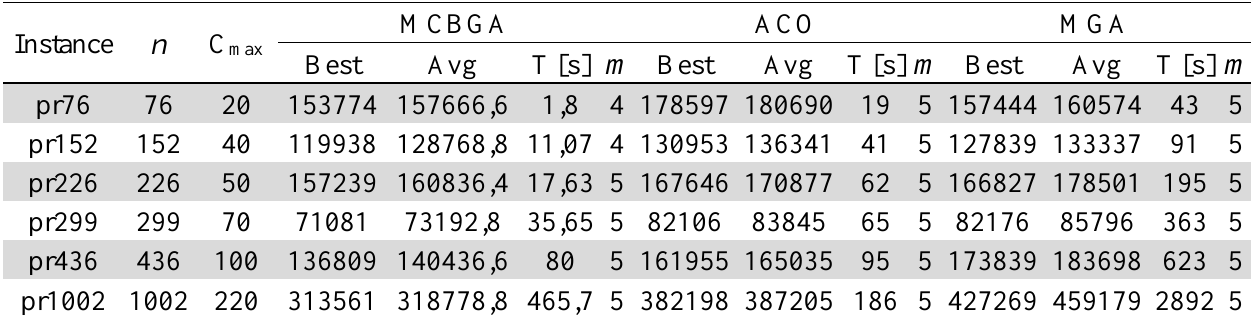
Comparison of results of the algorithms MCBGA, ACO and